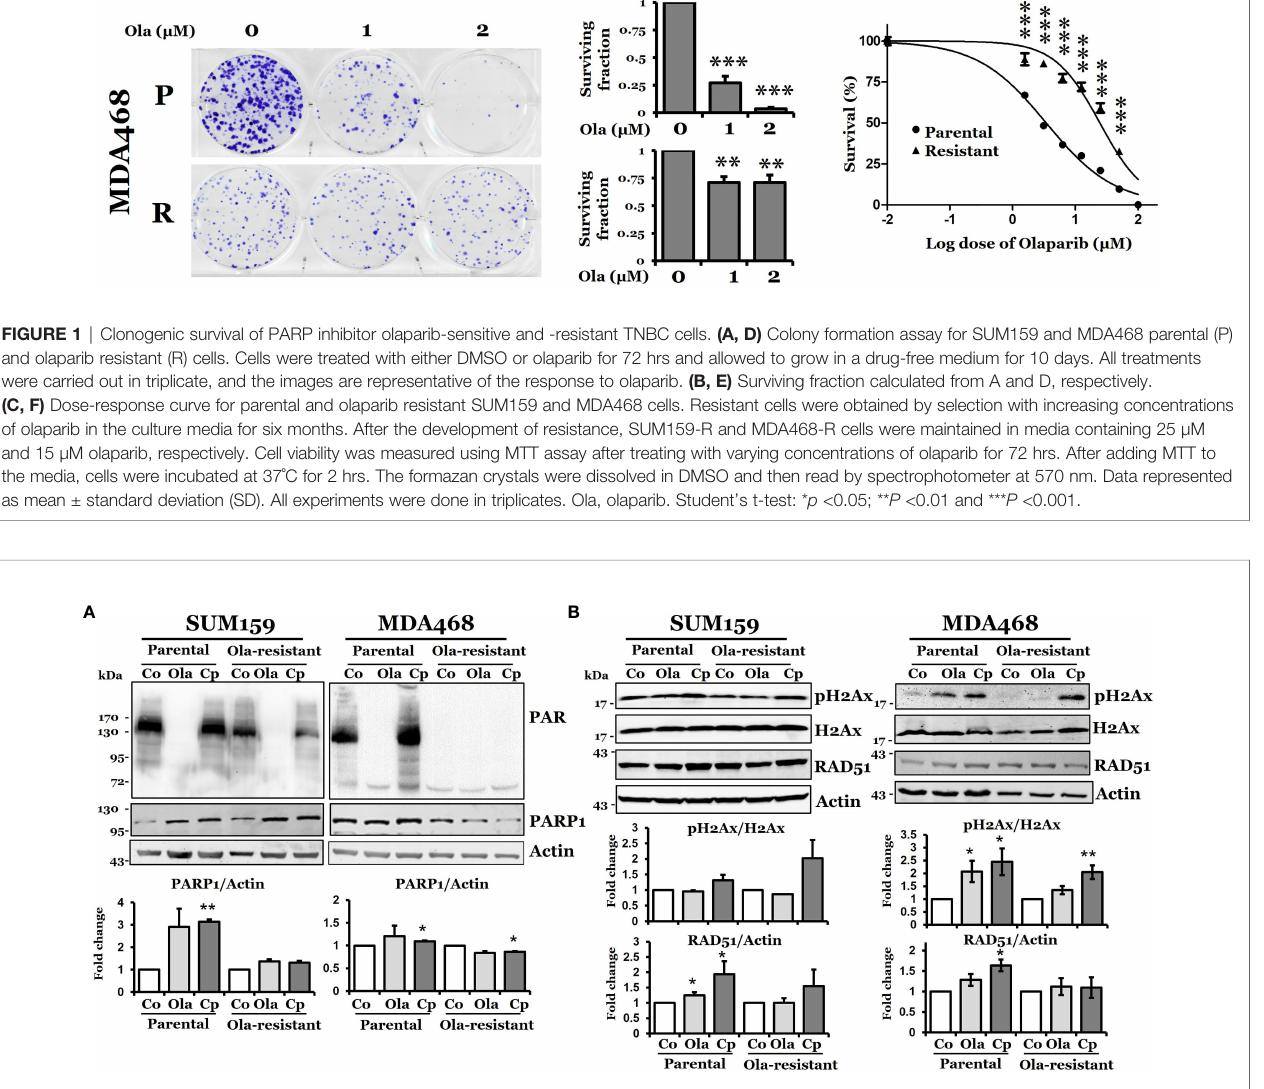
FIGURE 2 | DNA damage response in olaparib-sensitive and -resistant TNBC cells. Western blot analysis of DNA damage response associated proteins, PAR, PARP-1 (A) , pH2AX, and RAD51 (B) in parental and olaparib resistant SUM159 and MDA468 cells. Cells were treated with 5 µM olaparib or 2 µM cisplatin for 24 hrs. SUM159-R and MDA468-R cells were maintained in drug-free media 2-3 days before the experiment. For the determination of band density, NIH ImageJ 1.5Oi software was used. Band densities were normalized against Actin or total H2AX. Images are representative of three independent experiments. Co, control; Ola, olaparib and Cp, cisplatin. Student ’ s t-test: * p < 0.05 and ** p < 0.01.